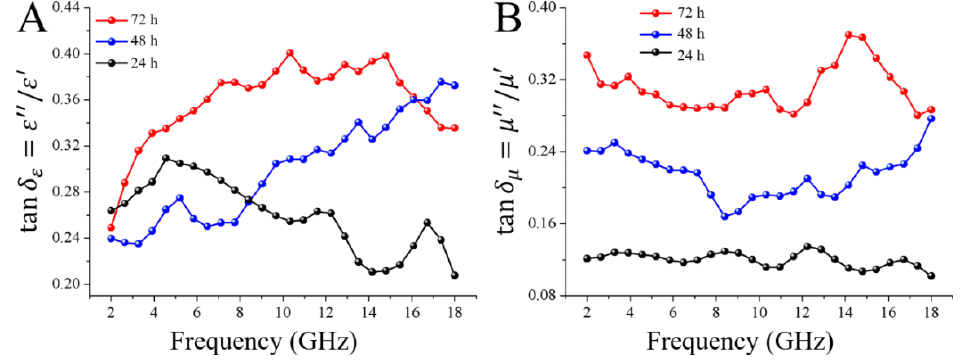
Figure 8. Frequency dependences of tan δ ε and tan δ µ of magnetic wood: 24 h (black), 48 h (blue), and 72 h (red).